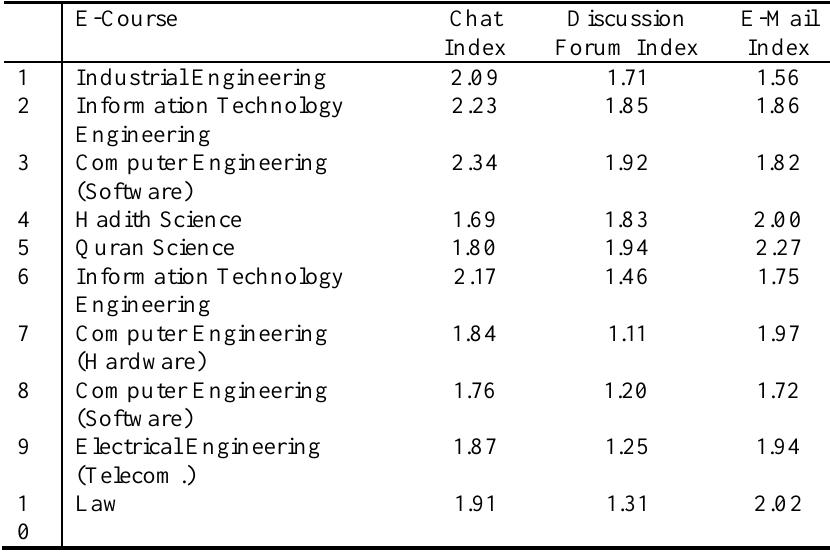
Values of the Three Interaction Method